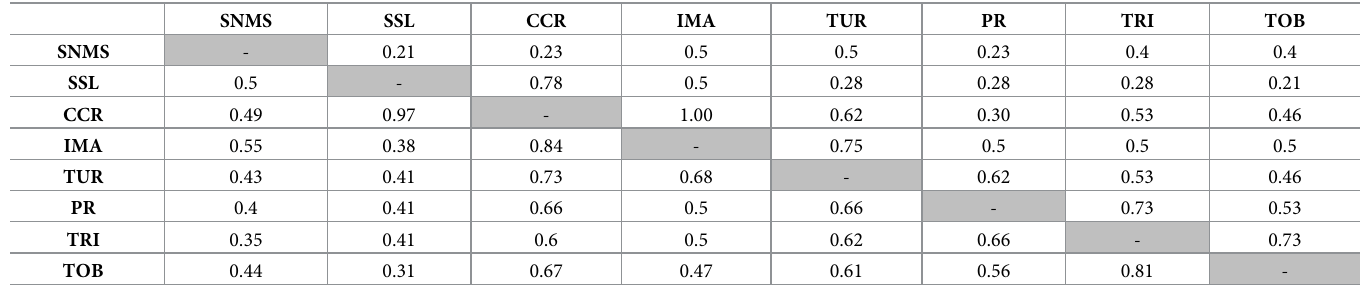
Table 3. Matrix of Simpson´s similarity index of amphibians (top) and reptile (bottom) between all regions. SNMS SSL